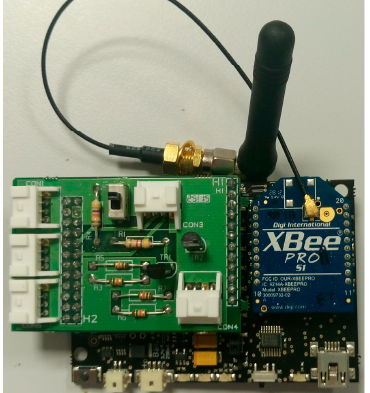
Figure 8. UcoBee Version 1 wireless node.